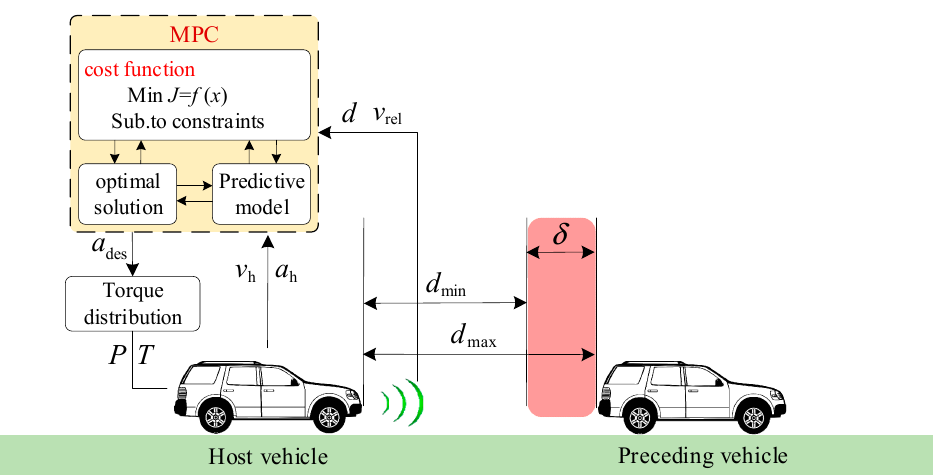
Figure 6. Schematic of the proposed EOCFC strategy.